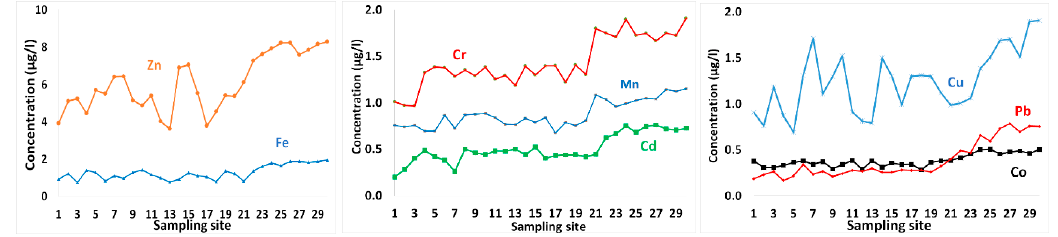
Figure 5. Metal contents in surface seawater in GoA, Jordan.